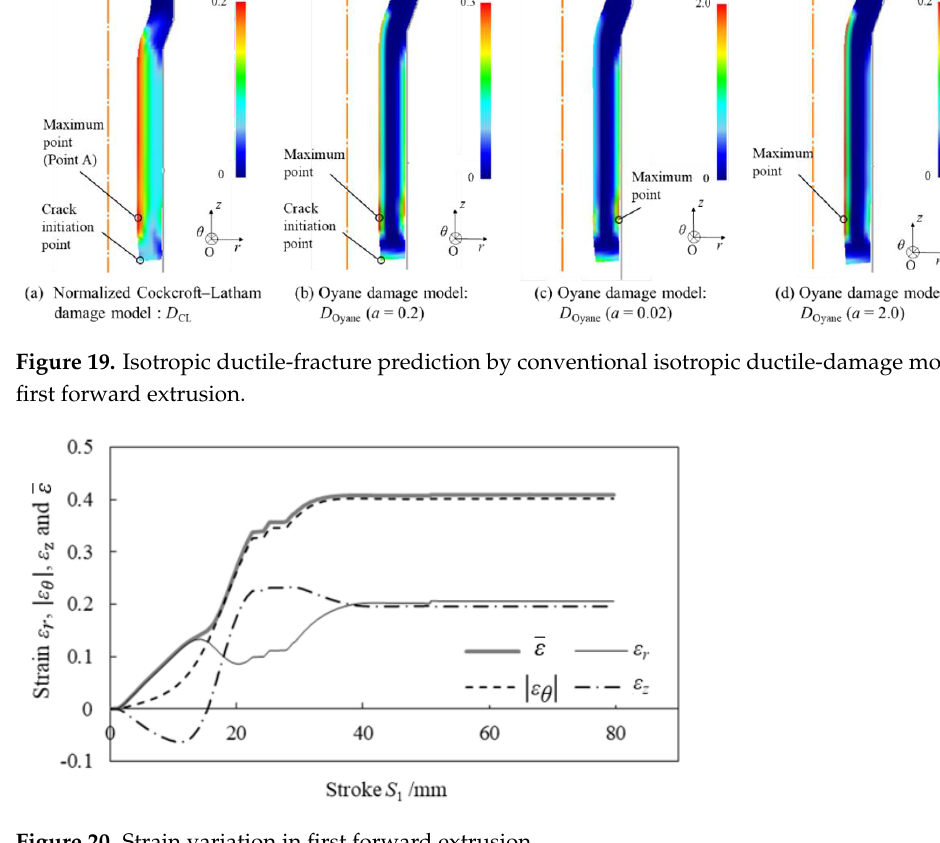
Figure 20. Strain variation in first forward extrusion.